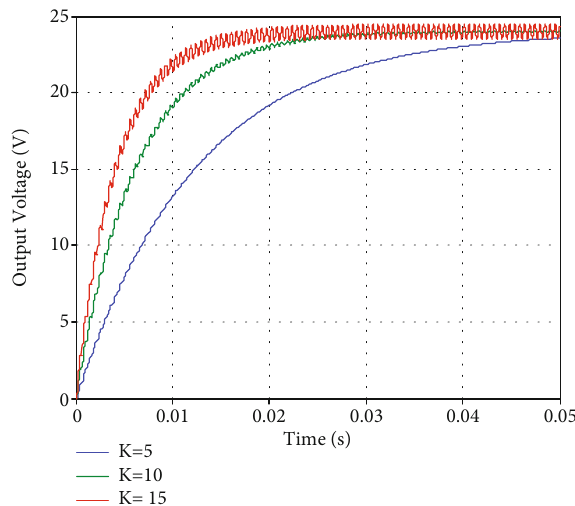
Figure 14: Simulated results of V various K .